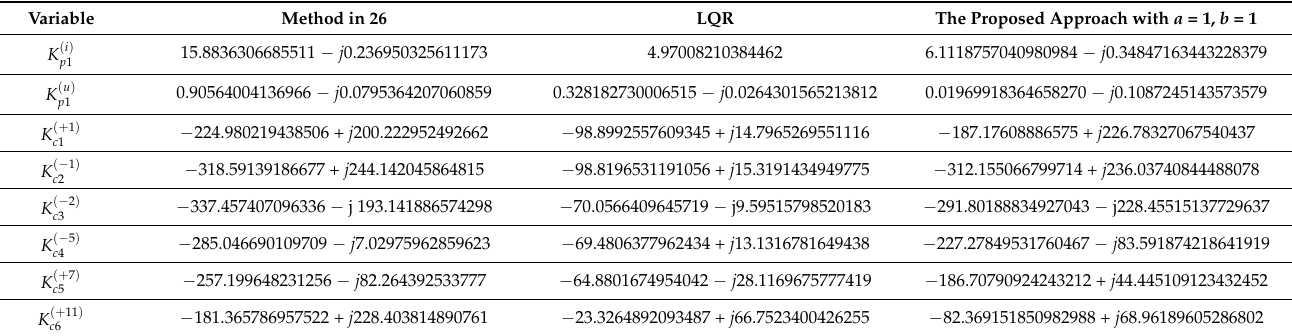
Table 3. Values of the control